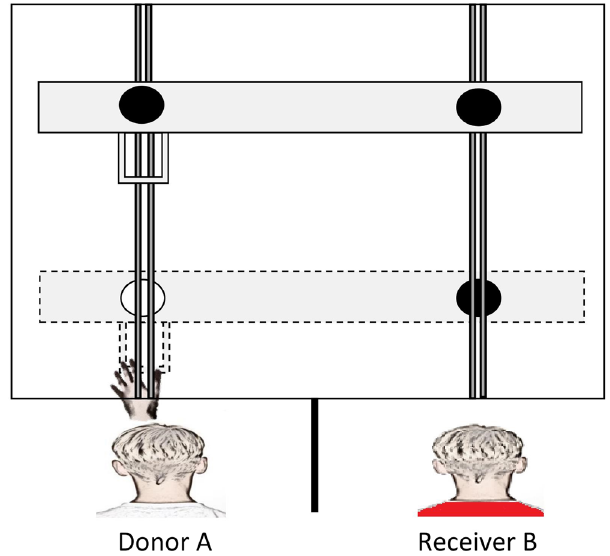
Figure 1. Bird’s-eye view of the experimental set-up used in the experimental trials of the agent condition. Note. Child A (the donor) is illustrated pulling the lower shelf forward using the handle attached to the box on the donor’s side of the apparatus. Child B (the receiver) is positioned in the receiver compartment awaiting the rewards coming into reach. The black circles represent the lower value rewards and the white circle the higher value